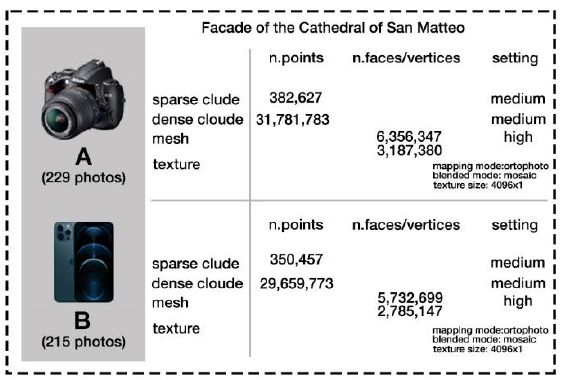
Figure 5. Photogrammetric process in Metashape- Agisoft. - Photogrammetric survey from iPhone